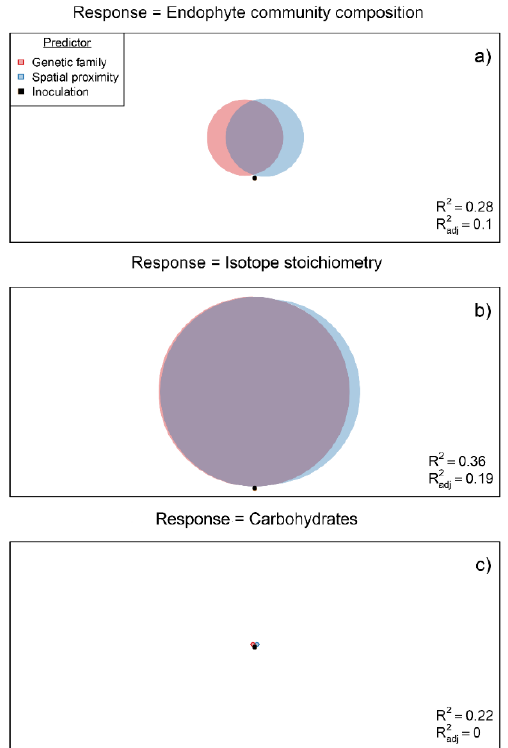
Figure 5. Variance partitioning analyses for the multivariate responses: ( a ) endophyte community composition, ( b ) isotopic stoichiometry, and ( c ) non-structural carbohydrate composition, with respect to maternal genetic family, inoculation treatment, spatial proximity, and their interaction. Circles, representing predictors, are scaled by their coefficient of partial determination, 𝑅 𝑝𝑎𝑟𝑡𝑖𝑎𝑙2 (i.e., the proportion of explained variation when conditioning on other predictors) in the variance partitioning models. Note that 𝑅 𝑝𝑎𝑟𝑡𝑖𝑎𝑙2 for the treatment was ≈ 0 for all models. The conventional multiple coefficient of determination, 𝑅 2 (i.e., the proportion variance explained in the model collectively by all the predictors), and the adjusted coefficient of the determination 𝑅 𝑎𝑑𝑗2 (i.e., 𝑅 2 adjusted for the spurious effect of additional variables, see the work of Aho (2016)) are shown in the lower right-hand corner of figures.